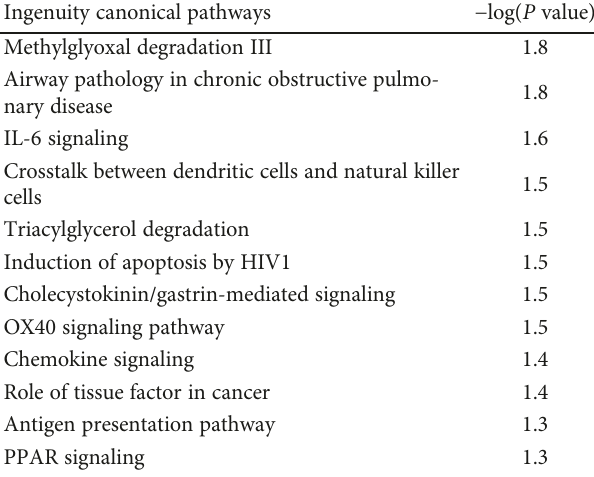
Table 5: Signi fi cant canonical pathways identi fi ed by Ingenuity Pathway Analysis (IPA) in HMECs after 24 h treatment with